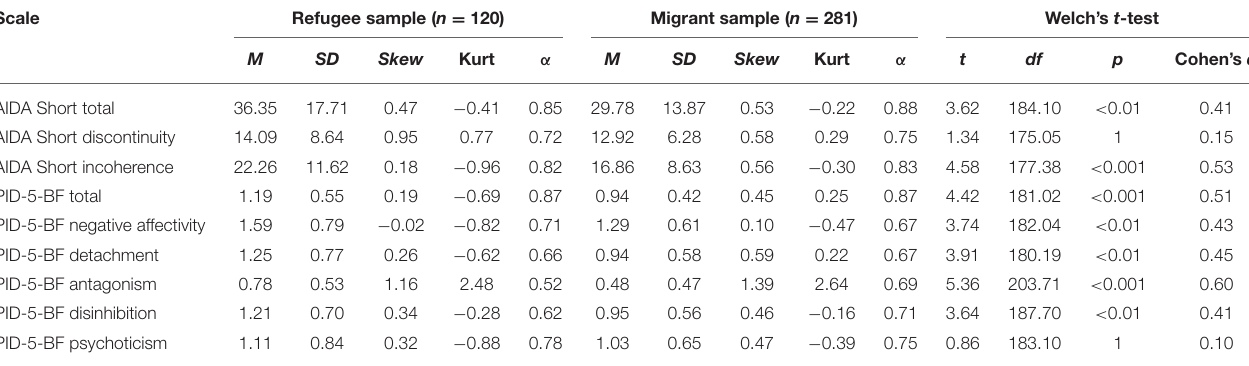
TABLE 1 | Descriptive statistics, reliability, and group differences between the refugee and migrant sample. Scale Refugee sample ( n = 120) Migrant sample ( n = 281) Welch’s t -test M SD Skew